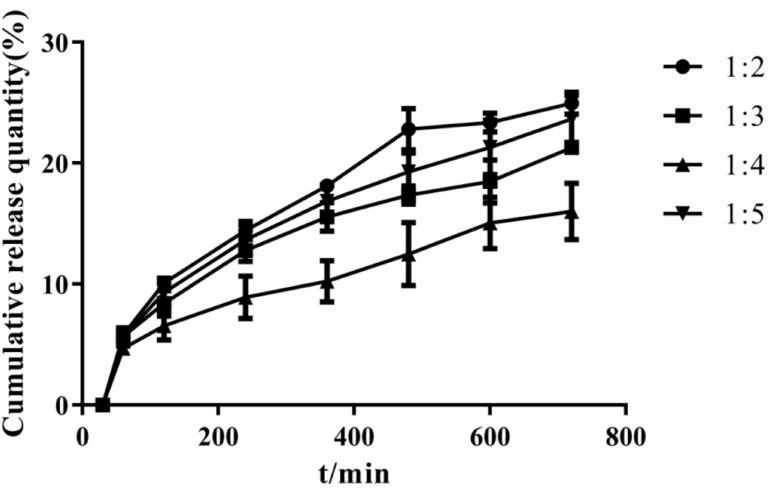
Figure 3. Dissolution curves of solid dispersion prepared by different drug loading